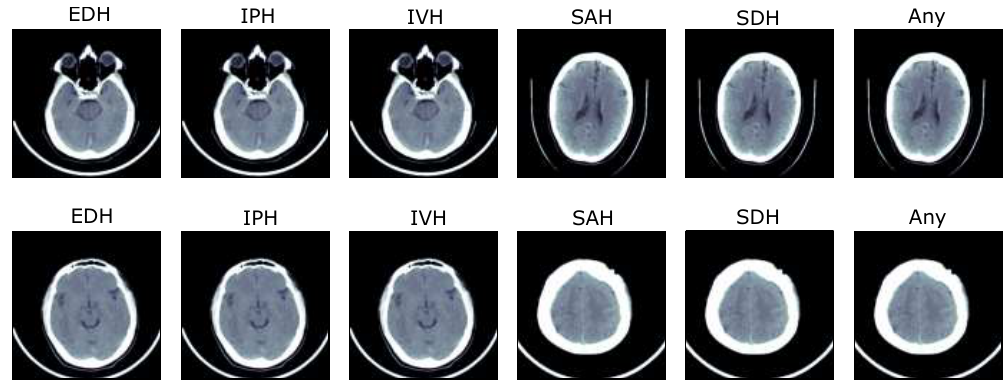
Figure 3. Representation of subtypes of